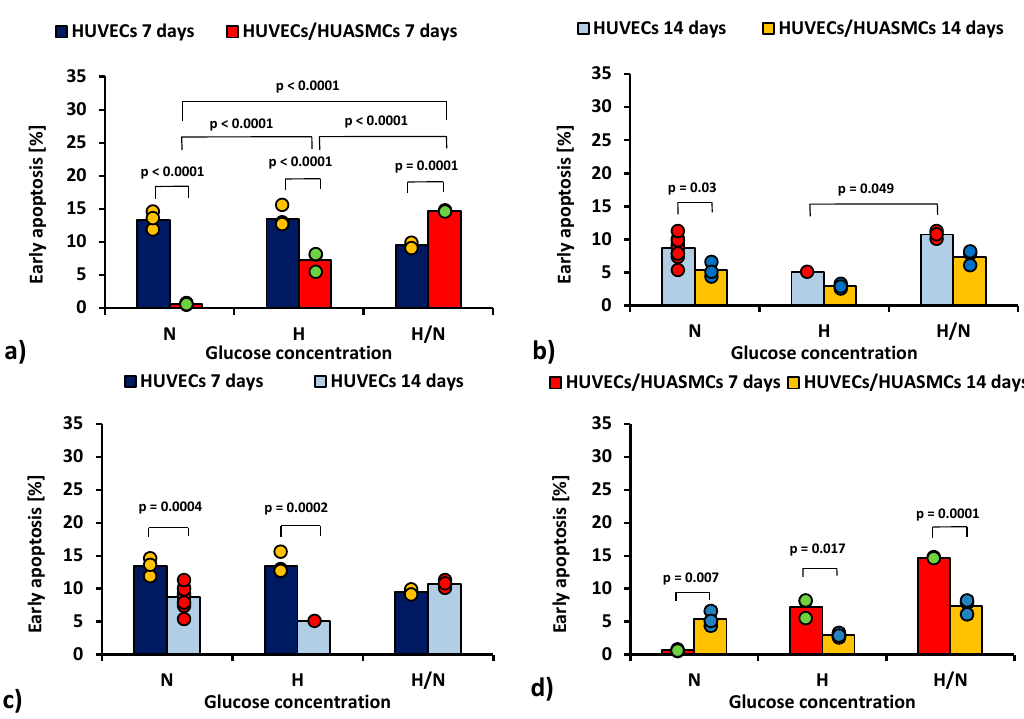
Figure 1. Percentage of early apoptotic HUVECs: after 7 days of culturing without HUASMCs or co-culturing with HUASMCs ( a ); after 14 days of culturing without HUASMCs or co-culturing with HUASMCs ( b ); after 7 and 14 days of culturing without HUASMCs ( c ); after 7 and 14 days of co-culturing with HUASMCs ( d ); in normal (N), high (H), or variable (H/N) glucose concentration on PSU flat membranes covered with fibronectin. The data are presented as scatter plot (yellow, green, red and blue dots) with corresponding bar graphs.